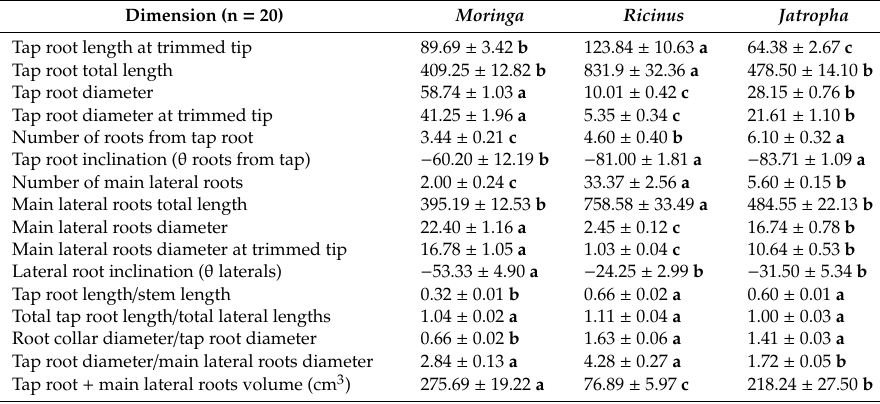
Figure 3. Root measurements taken at tap and main lateral roots indicated in Table 4. Table 6. Average root dimensions (mm) ± SE of Moringa oleifera , Ricinus communis , and Jatropha curcas 83 days after root pruning and transplant.